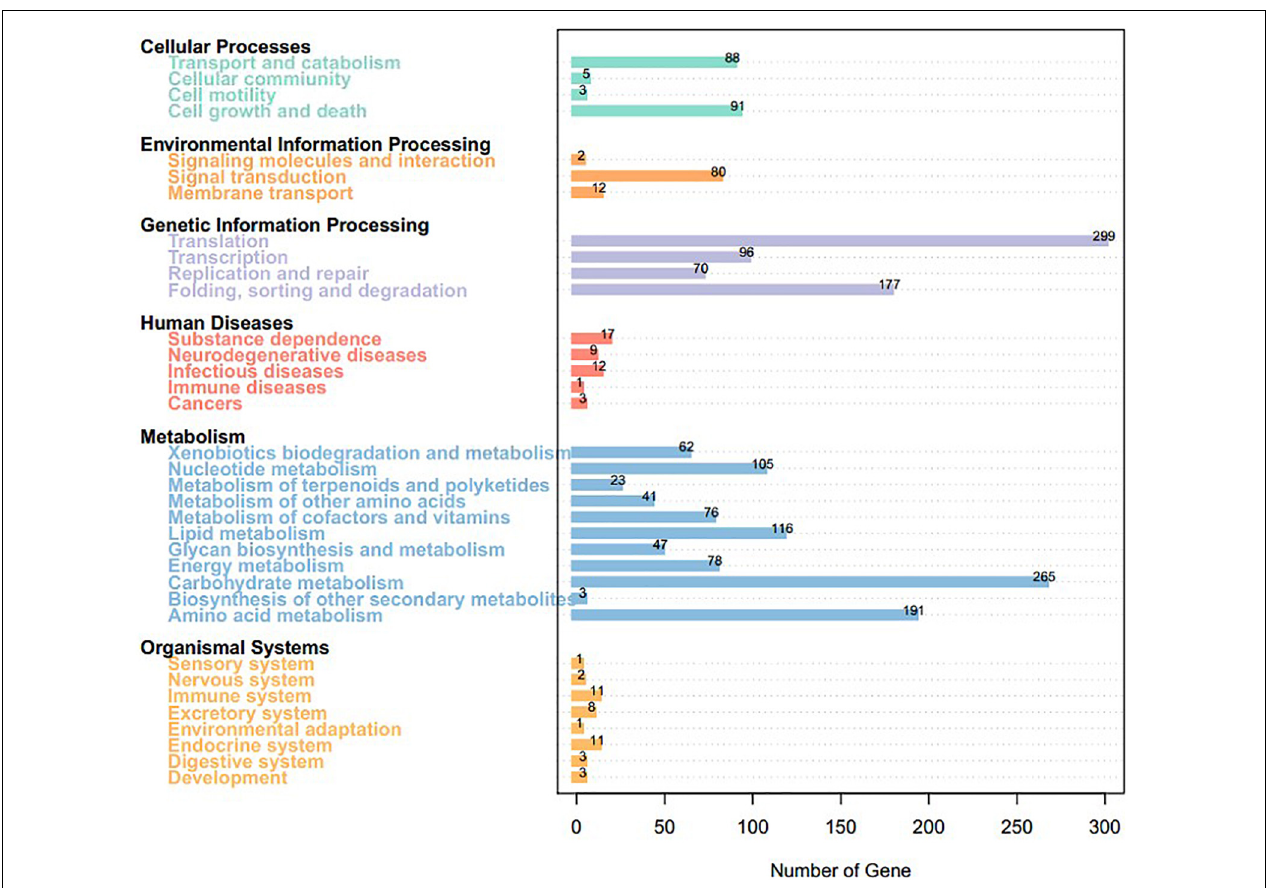
FIGURE 4 | Kyoto Encyclopedia of Genes and Genomes pathway annotation of Sarcomyxa edulis